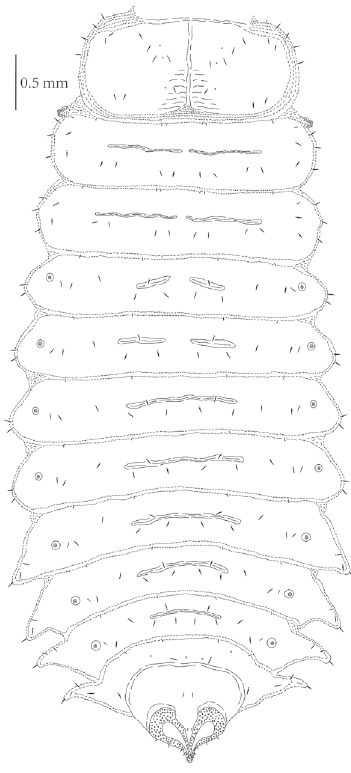
Figure 17. Prionispa champaka , last instar larva, dorsal